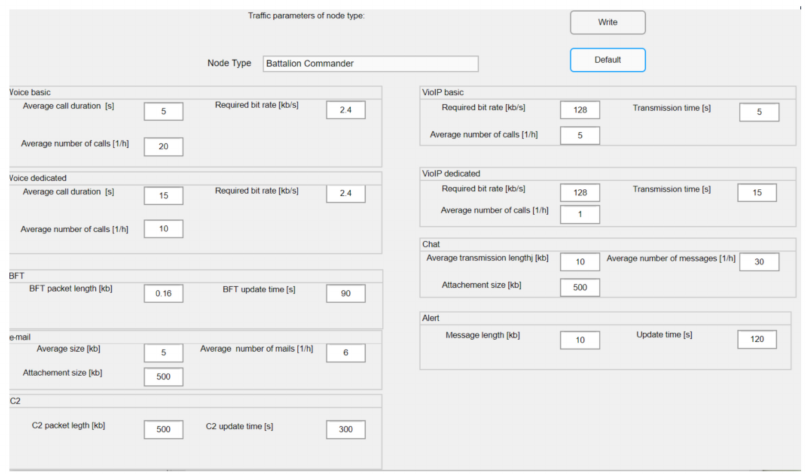
Figure 8. Traffic parameters